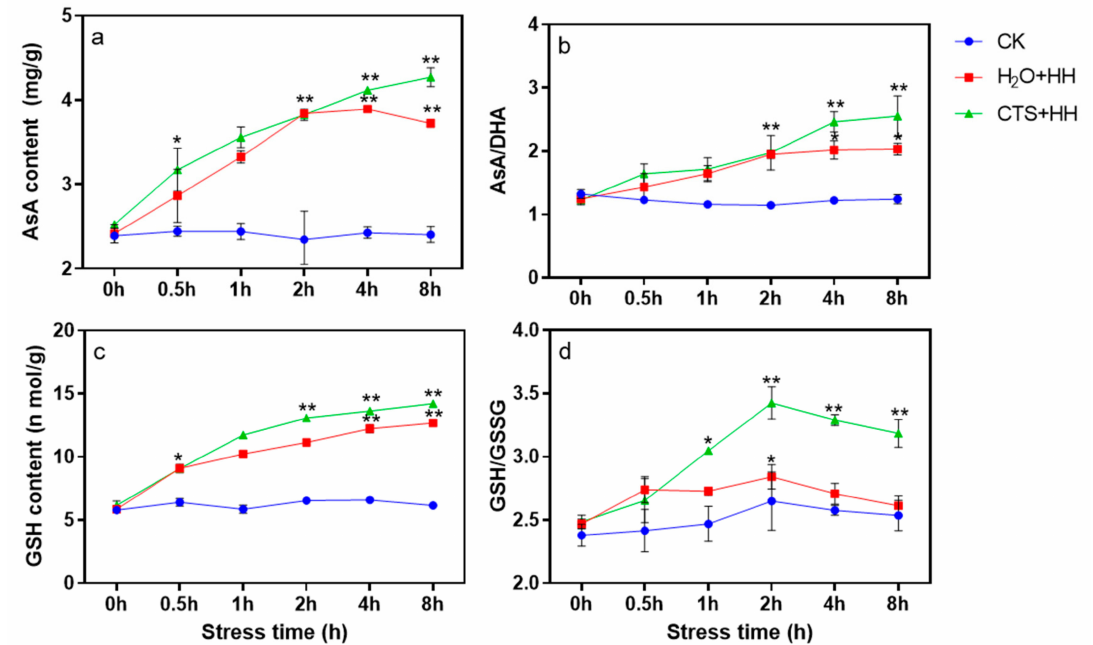
Figure 7. Effect of CTS on the AsA and GSH contents and the AsA/DHA and GSH/GSSG ratios in strawberry seedlings under high-temperature and high-light stress. ( a ) ascorbic acid content, AsA content; ( b ) the ratio of ascorbic acid to oxidized ascorbic acid, AsA/DHA; ( c ) glutathione content, GSH content; ( d ) ratio of glutathione to oxidized glutathione. CK: H 2 O + 23 ◦ C + 400 µ mol · m − 2 · s − 1 ; H 2 O + HH: H 2 O + 38 ◦ C + 1800 µ mol · m − 2 · s − 1 ; CTS + HH: CTS + 38 ◦ C + 1800 µ mol · m − 2 · s − 1 . * indicates a significant difference between the treatments (Duncan’s multiple range test; p < 0.05); and **, a very significant difference (Duncan’s multiple range test; p <